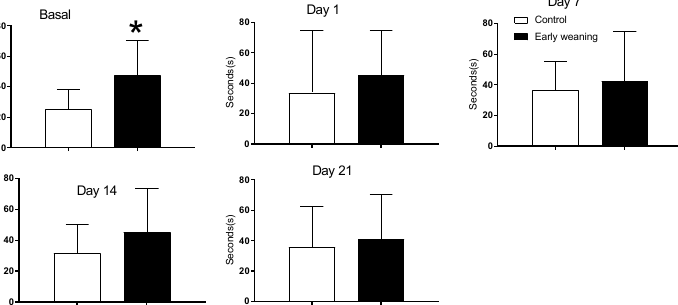
Figure 2. Effect of Early Weaning associated to chronic stress over time spent in central platform of the elevated plus maze. Data were obtained from animals during their 166–168 days of age (basal analysis) and during days 1 (168–170 days of age), 7 (174–176 days of age), 14 (181–183 days of age) and 21 (187–189 days of age) of alimentary stress. t -test n = 8. Data expressed as mean ± SD. * p < 0.05 vs.